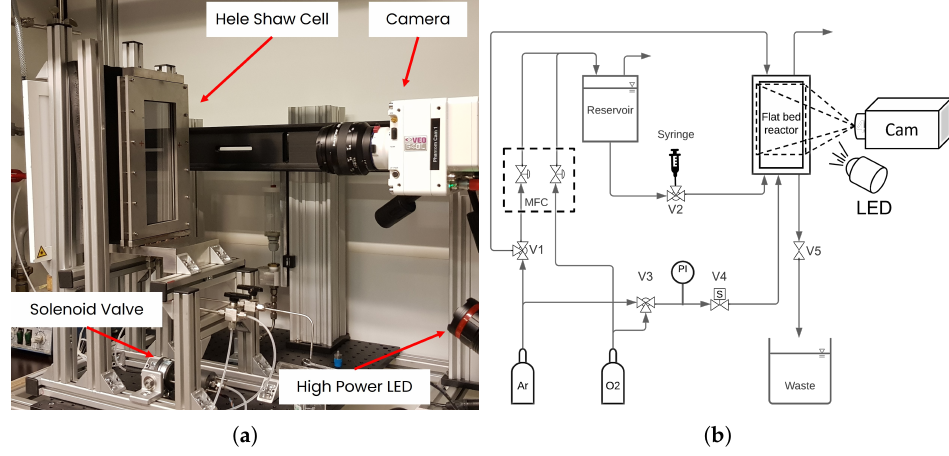
Figure 1. ( a ) Experimental setup of the flat-bed reactor used for the PIV and LEDIF measurements at the TUHH and ( b ) schematic sketch of the used